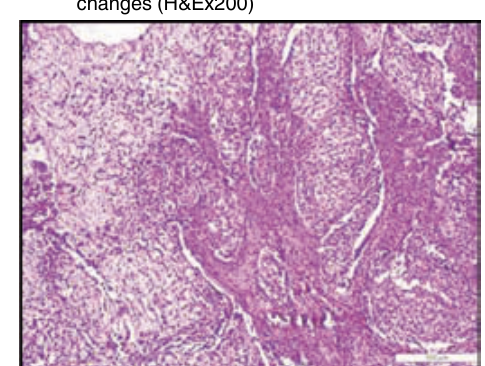
Fig.1. Ductal carcinoma - proliferating neoplastic cells within duct lumen (H&Ex400)